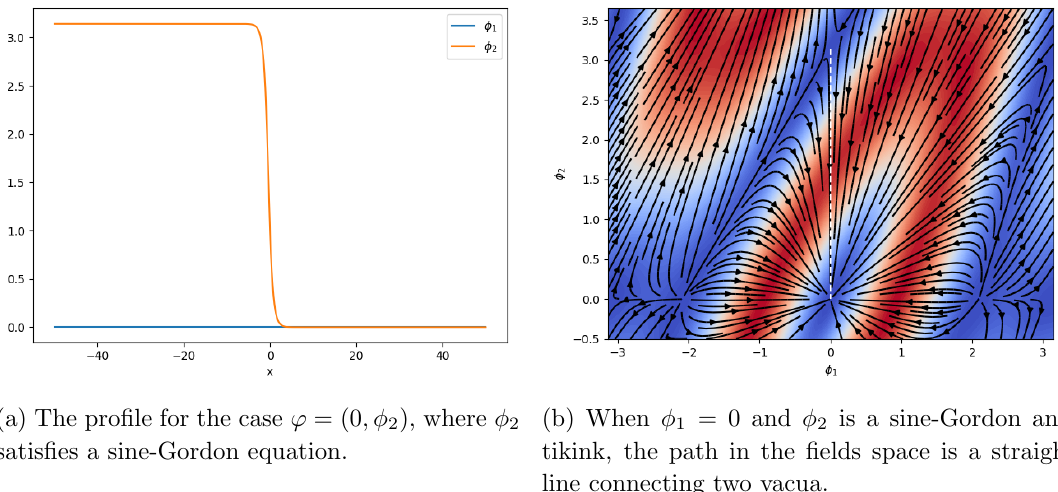
Figure 9. The sine-Gordon theory appears as a submodel of the g 2 FKZ model.